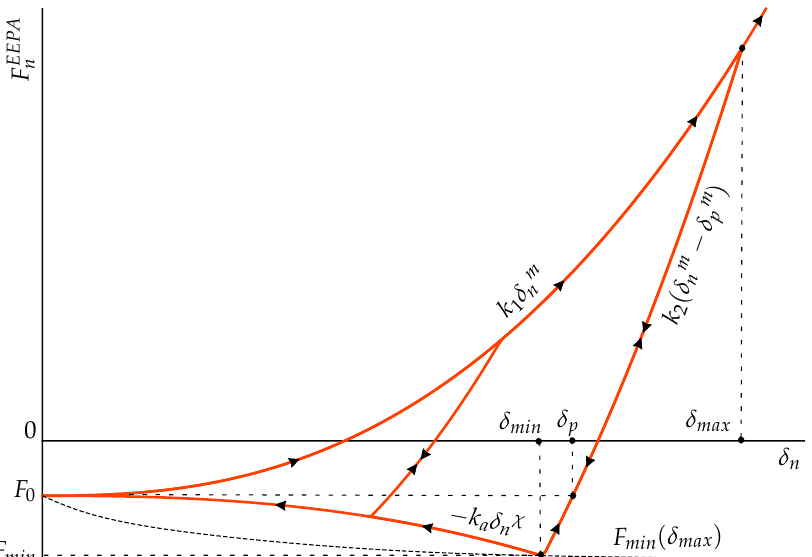
Figure 3. EEPA model force-displacement relation in the normal